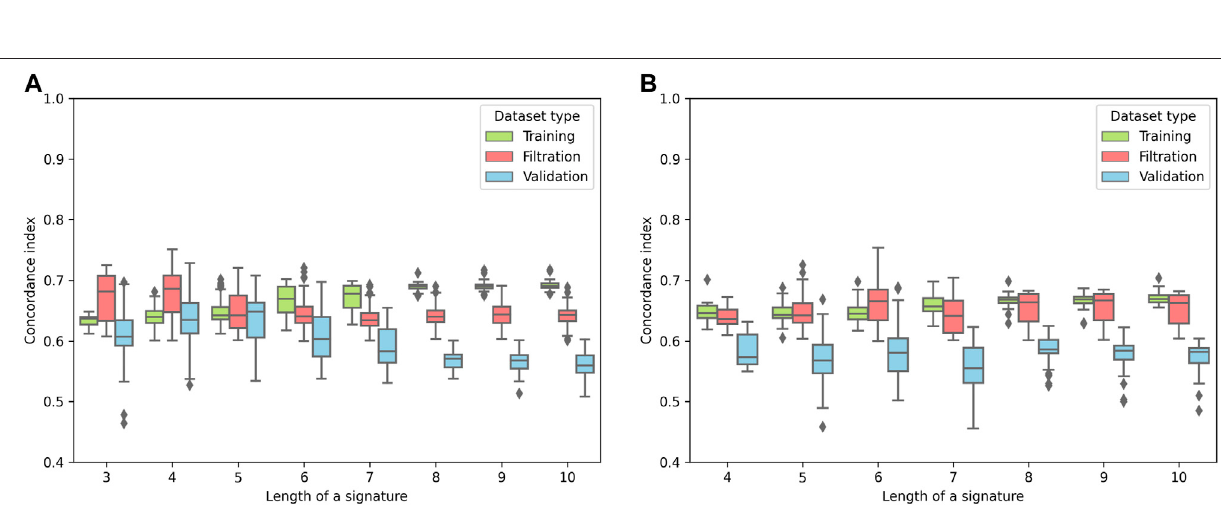
Frontiers in Genetics |